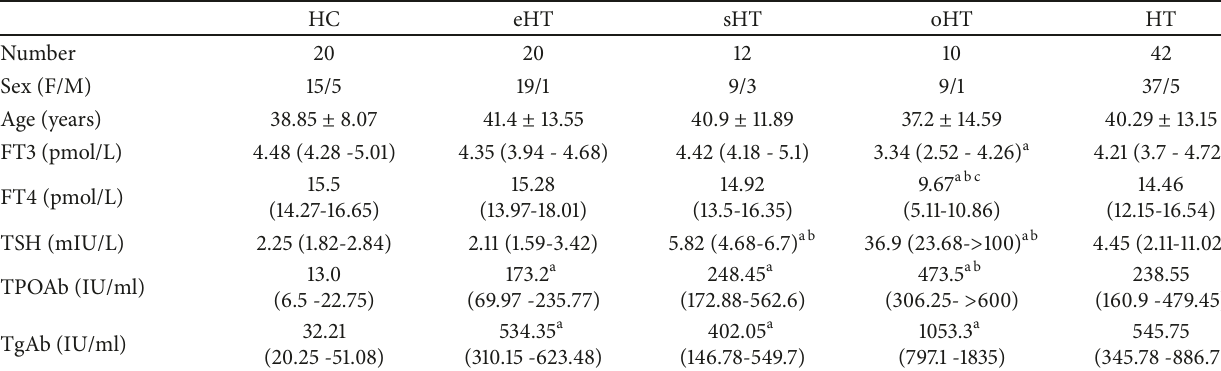
Table 1: Clinical and demographic features of the